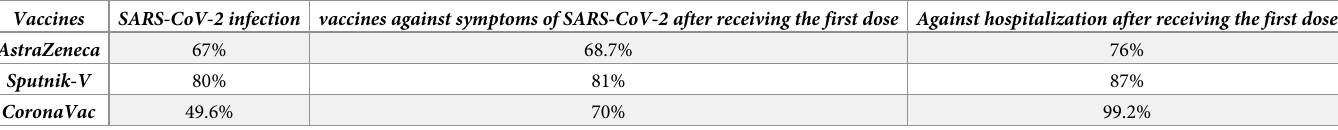
Table 1. The efficacy of the vaccines against symptomatic, severe, and hospitalization SARS-CoV-2 infection. Vaccines SARS-CoV-2 infection vaccines against symptoms of SARS-CoV-2 after receiving the first dose Against hospitalization after receiving the first